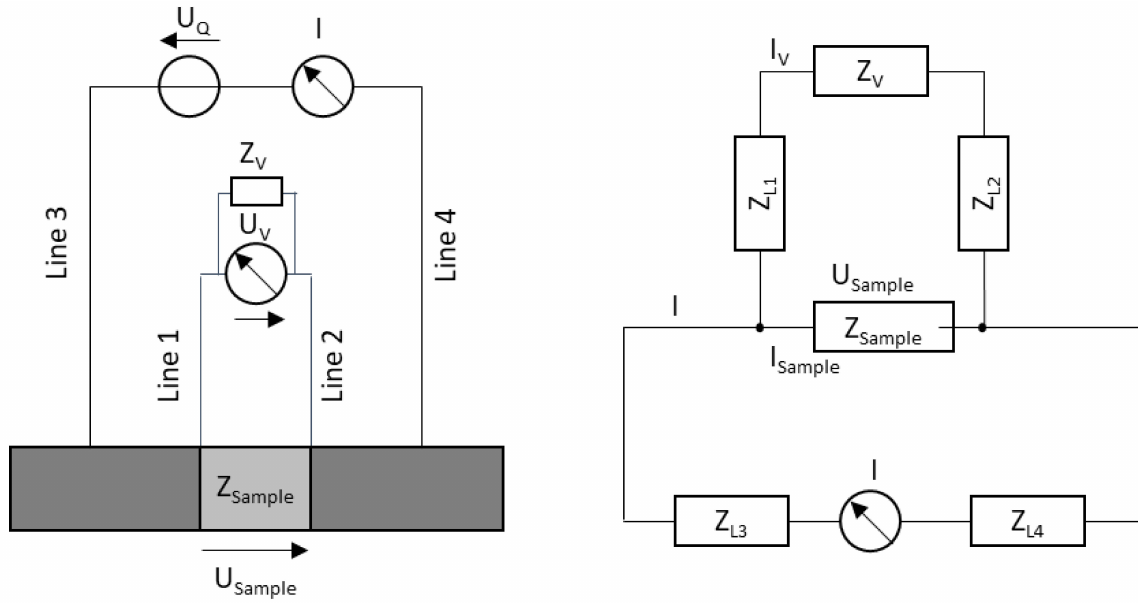
Figure 4. Structure of the four-wire measurement method ( left ) and equivalent circuit ( right